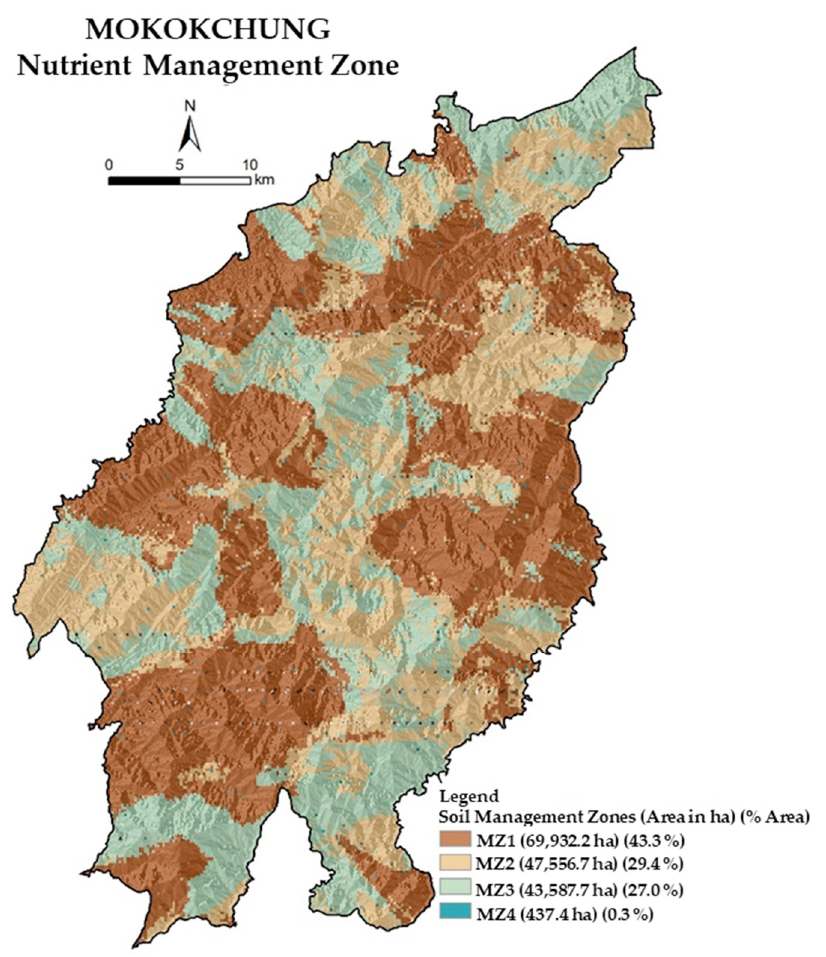
Figure 8. Map of management zones for four clusters in India’s north-eastern Himalayan area.